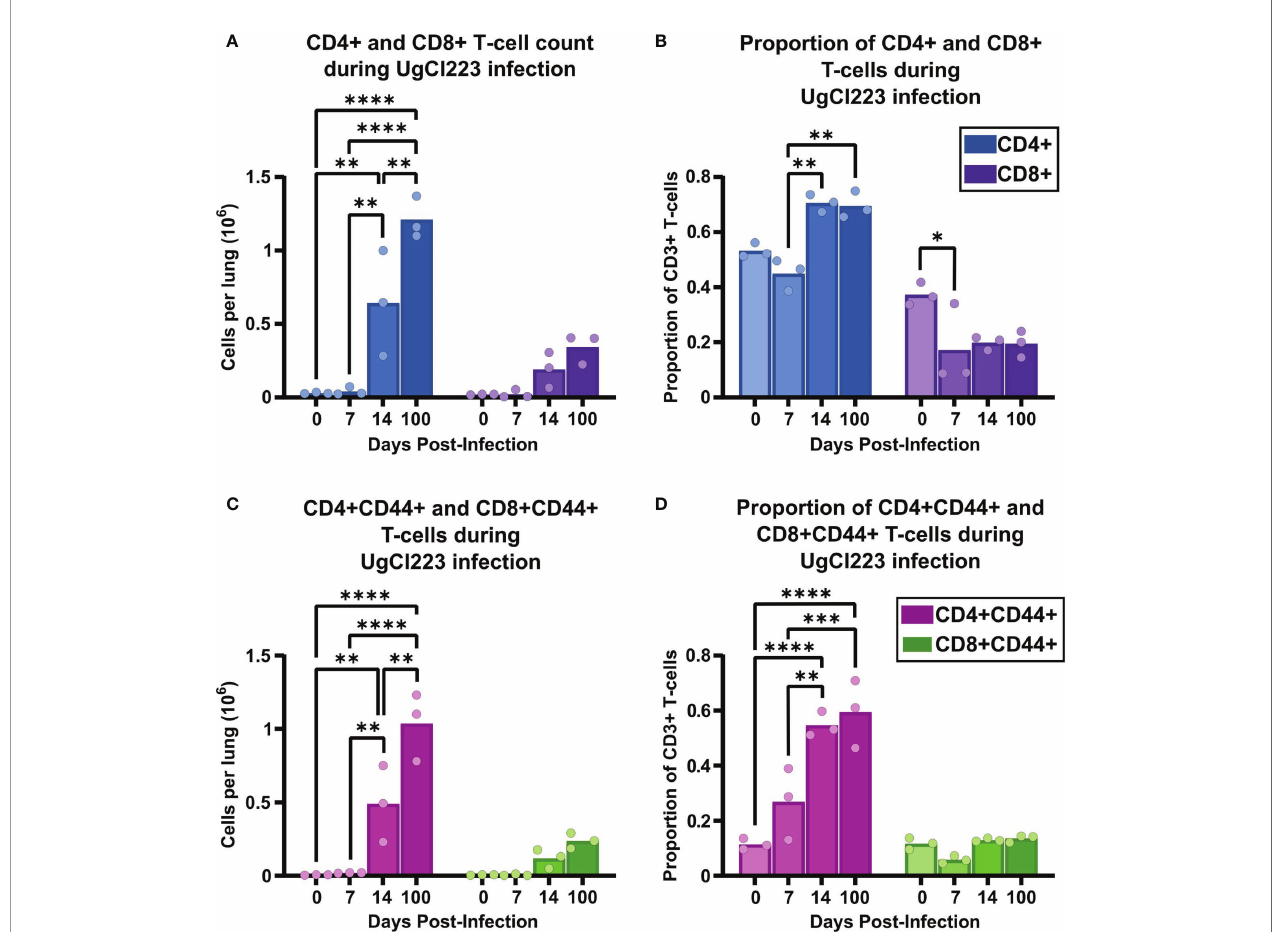
FIGURE 5 | The adaptive immune response to UgCl223 infection within the lungs was dominated by CD4 T-cells. C57BL/6 mice were intranasally infected with UgCl223. Single cell lung suspensions were generated at 0, 7-, 14-, and 100-days post-infection. (A) Total CD4+ and CD8+ T-cell counts, (B) Total CD4+ and CD8 + T-cell proportion out of total CD3+ T-cells, (C) CD4+CD44+ and CD8+CD44+ activated T-cell counts, and (D) CD4+CD44+ and CD8+CD44+ activated T-cell proportion out of total CD3+ T-cells were quanti fi ed using fl ow cytometry. The gating strategy of the fl ow cytometric plots was doublet exclusion, exclusion of B220 +CD11c+CD11b+F4/80+NK1.1+/dead cells/CD45 IV-labelled cells, gating on CD3+ T-cells, gating on CD4+ and CD8+ T-cells, and then gating on CD4+CD44+ and CD8+CD44+ T-cells. n = 3 mice per group. *p < 0.05, **p < 0.001, ***p < 0.0001, ****p < 0.00001 by two-way ANOVA. with Bonferroni correction. Statistical signi fi cance was noted between CD4+ vs. CD8+ groups, and CD4+CD44+ vs. CD8+CD44+ groups, but is not indicated on the